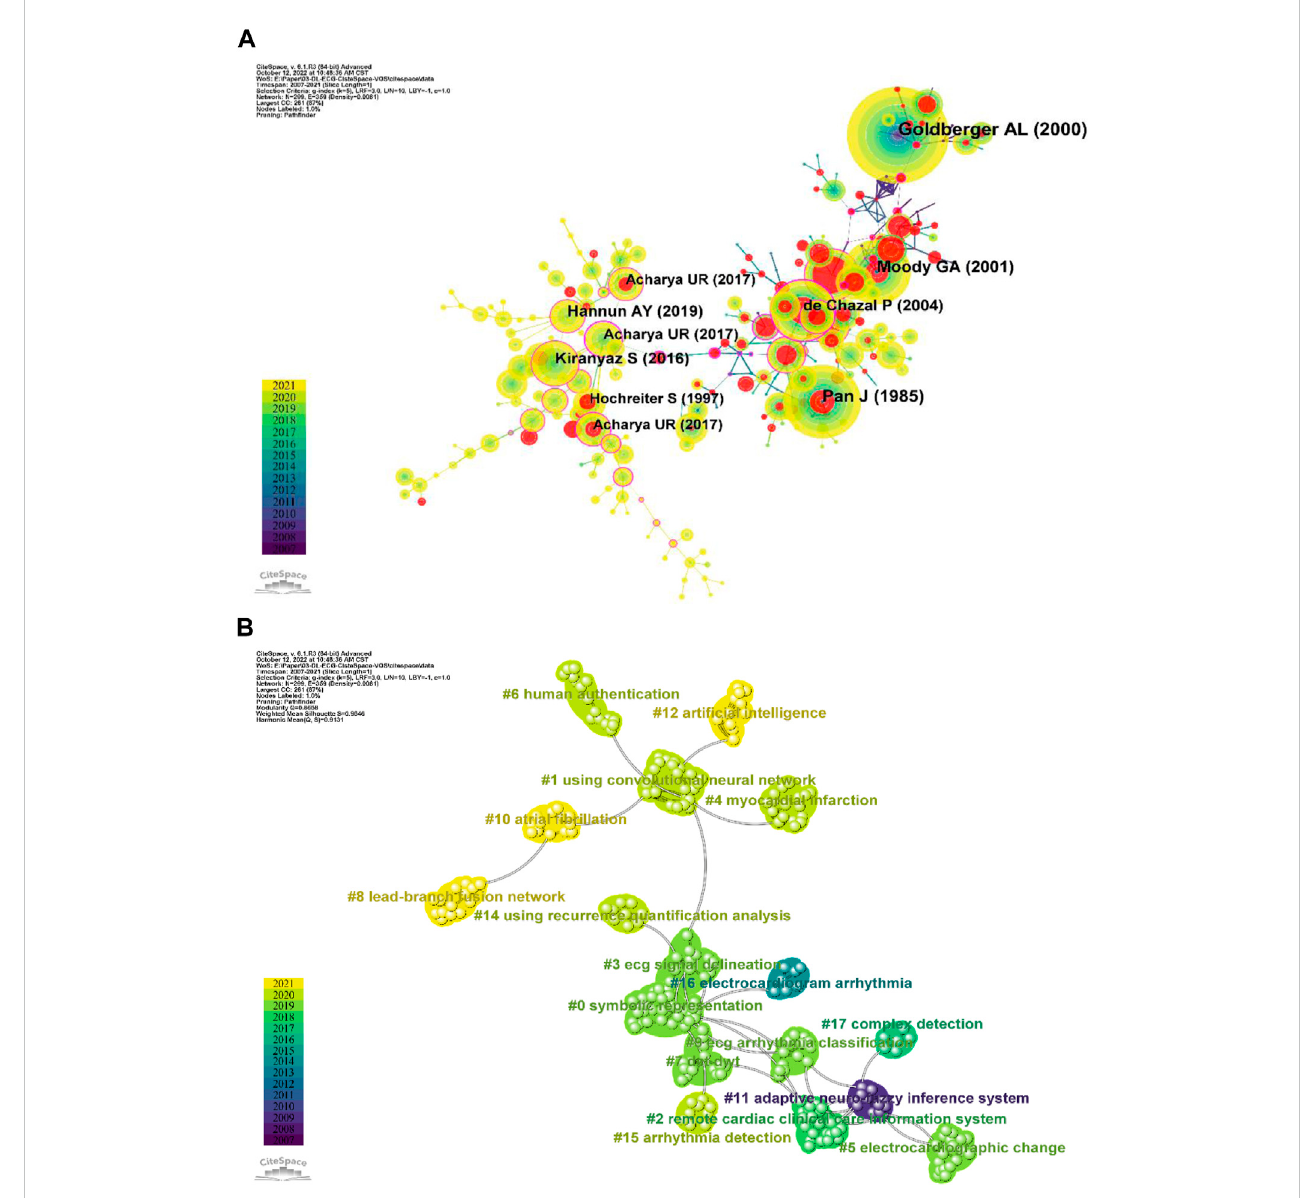
FIGURE 7 (A) The CiteSpace co-citation knowledge domain map for references changing over the years. The frequency of citations is indicated by different node sizes,redcircleindicatesaburstofcitedreferences. (B) Clusteringknowledgevisualizationdomainmapforco-citationreferencesovertimeinCiteSpace.The evolution of research hotspots is shown with different colored